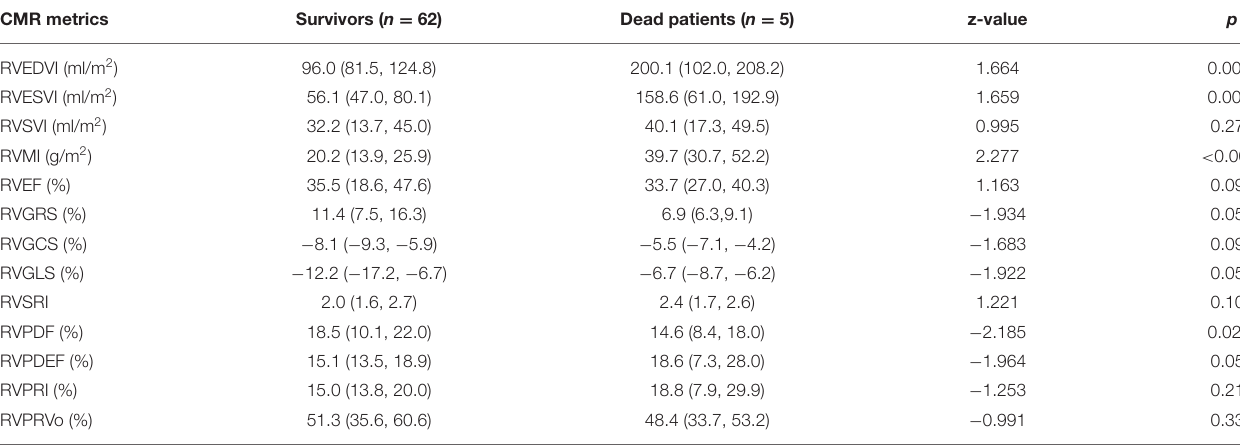
TABLE 4 | Comparison of right ventricular functional and flow metrics between survivors and deceased